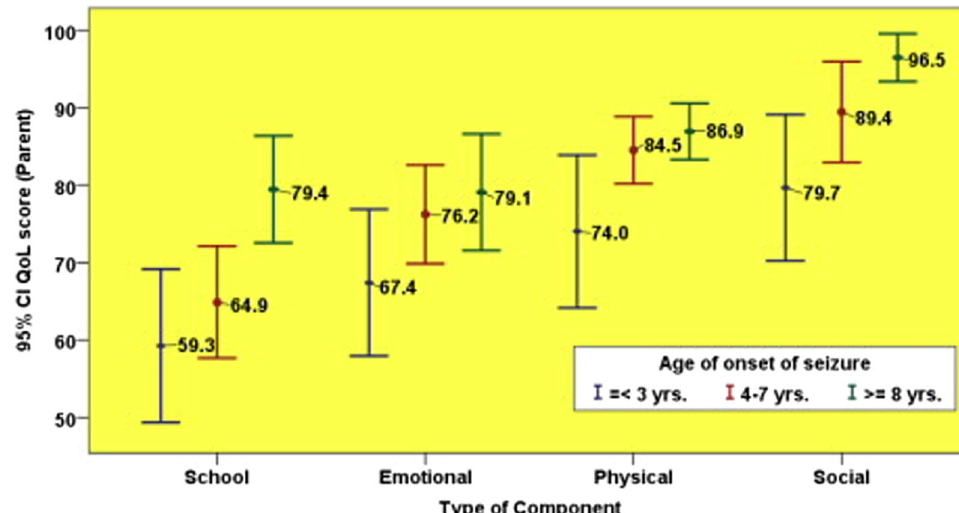
Fig. 4 Parent reported QOL in different components based on the age of onset of